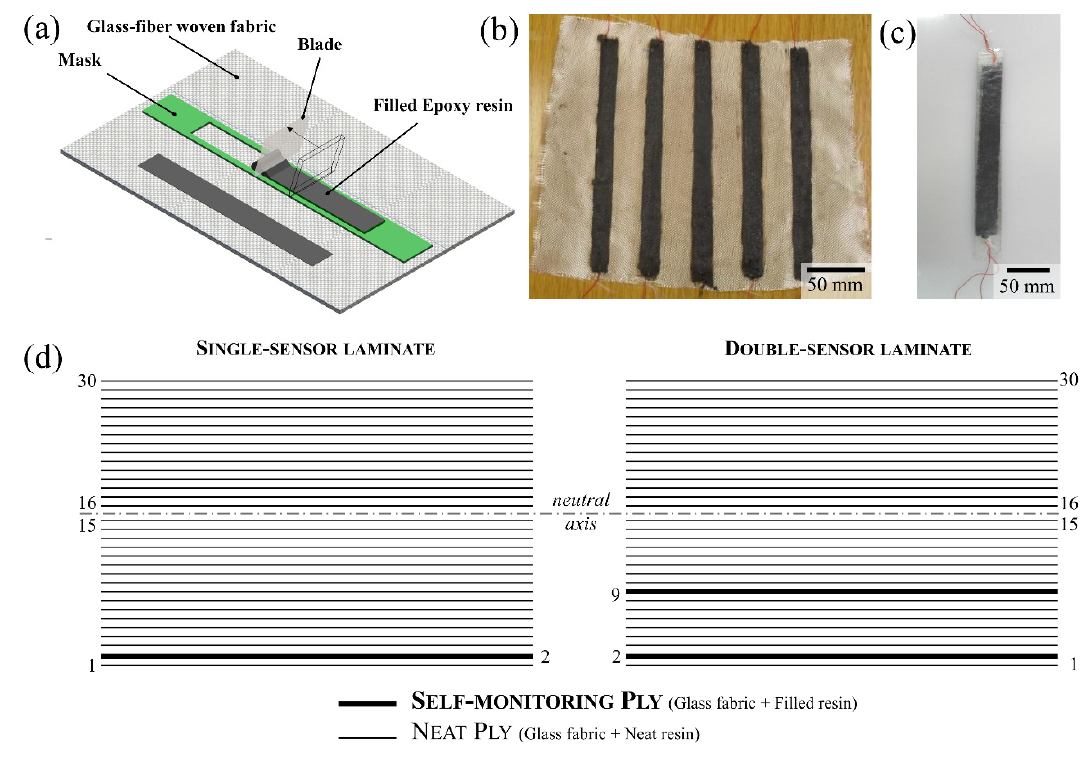
Figure 2. ( a ) Doctor blade technique schematics, ( b ) impregnated self-monitoring plies, ( c ) sensored laminate and ( d ) stacking sequence of laminates (dashed line represents the neutral axis).